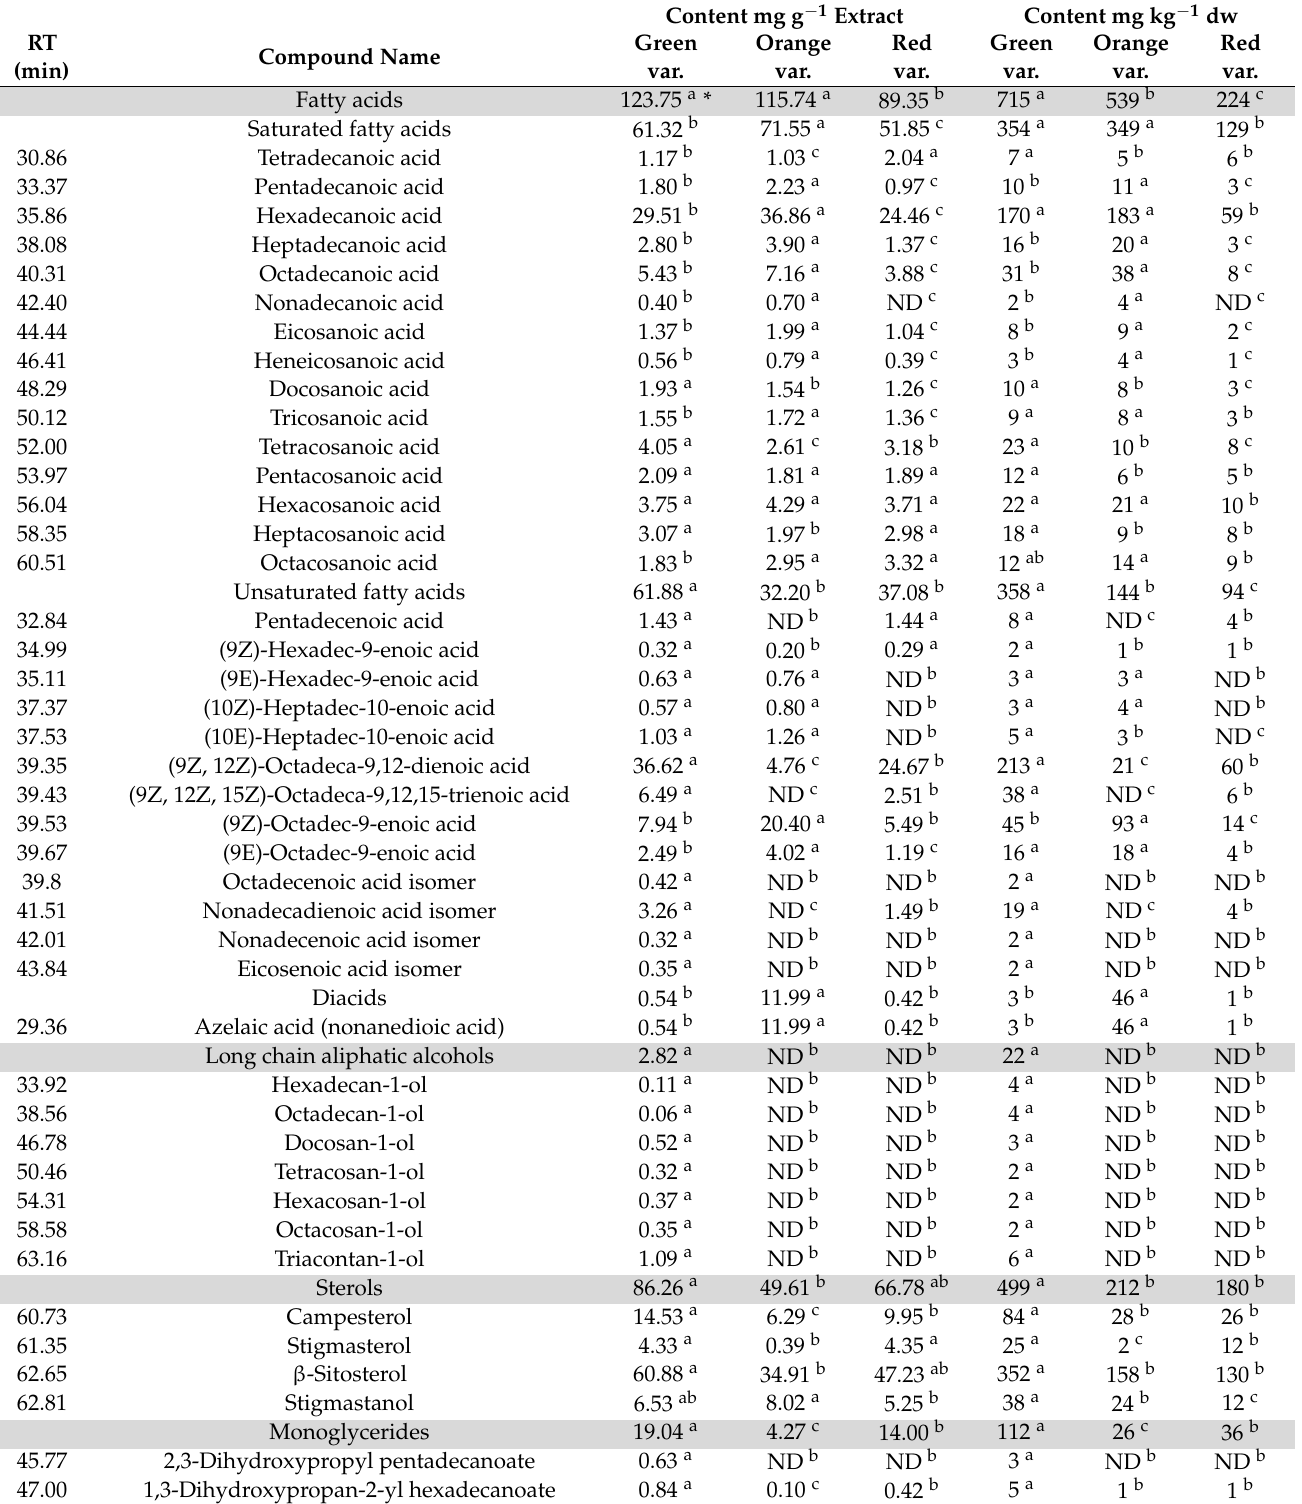
Table 2. Chemical composition of root lipophilic fractions from three varieties of Opuntia ficus-indica cultivated in